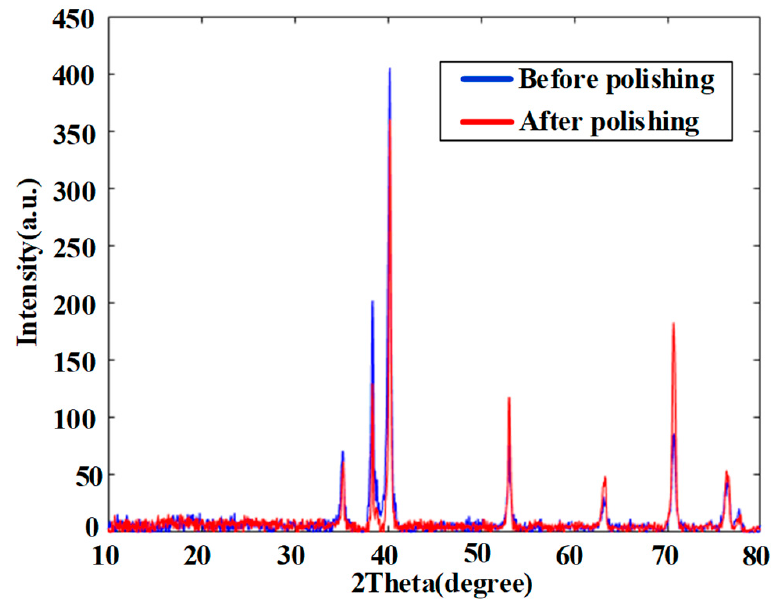
Figure 17. XRD of titanium alloy before polishing and after final polishing using PR bonnet.